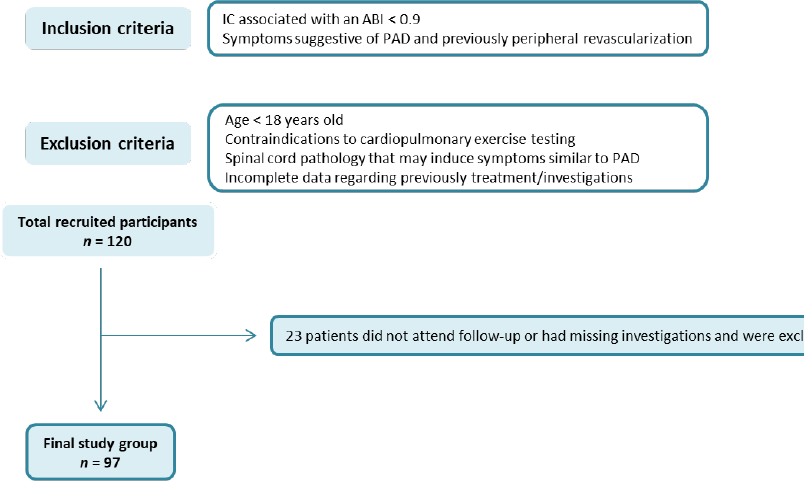
Figure 1. Flow chart of the studied group (IC: intermittent claudication; ABI: ankle-brachial index; PAD: peripheral artery disease).